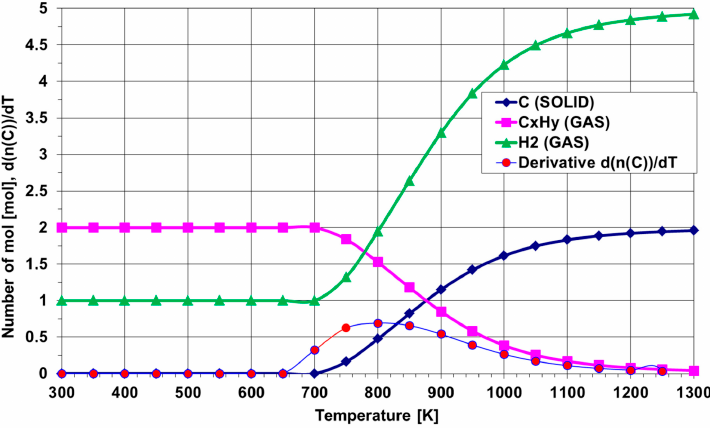
Figure 5. Thermal decomposition of the mixture of 1000 sccm of ethylene with 3000 sccm of hydrogen.